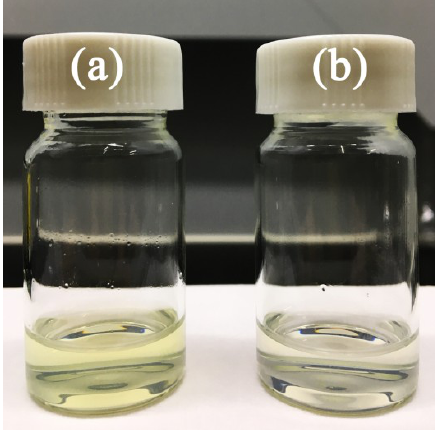
Figure 2. Visual observation of the quercetin–chitosan solution ( a ) before and ( b ) after adding the TPP solution.